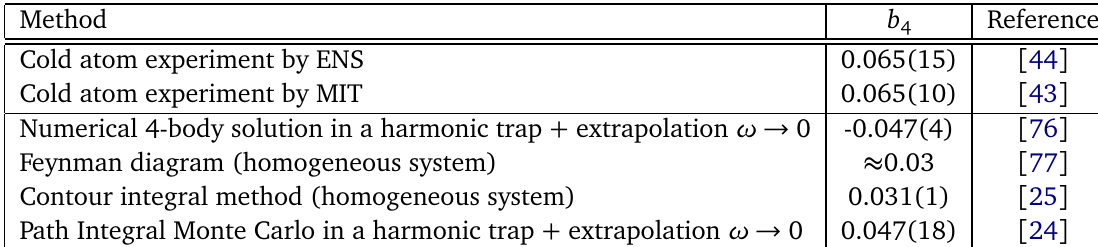
Table 1: Comparison of b obtained in experiments (first and second rows) and the- 4 ories (third to sixth